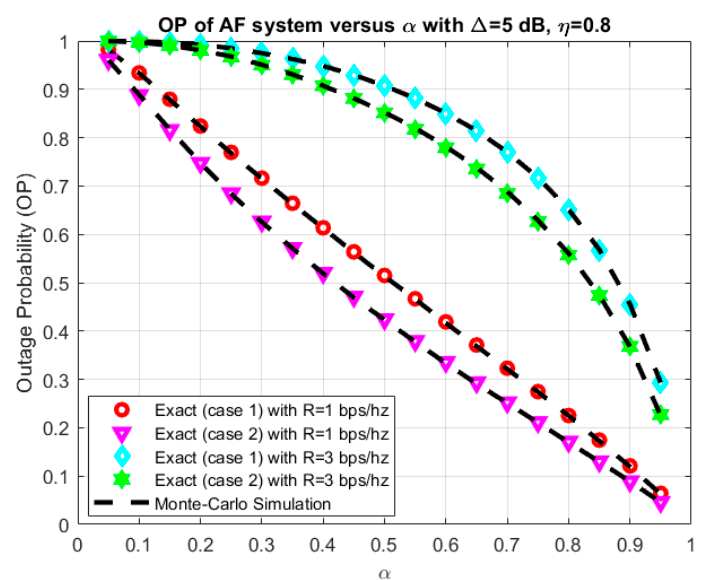
Figure 3. OP versus α . OP, outage probability.